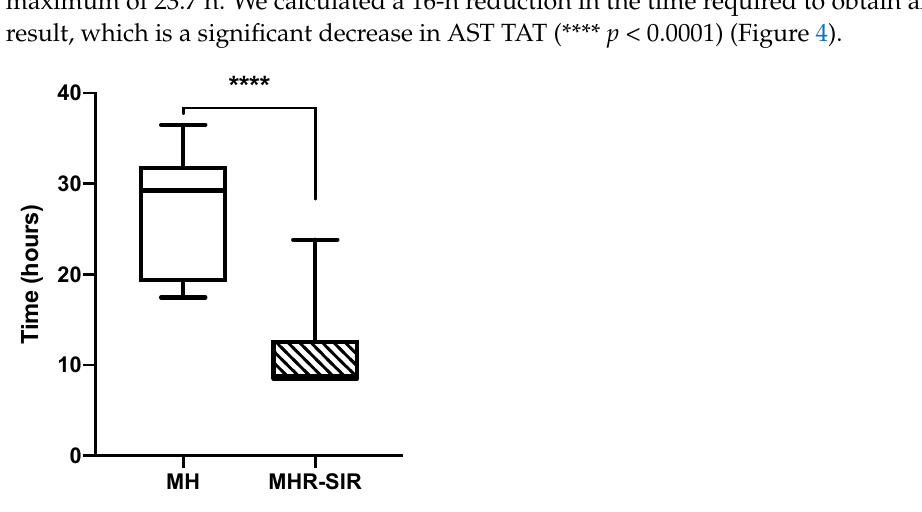
Figure 4. Comparison of time required to obtain the direct AST from a blood culture bottle for MH vs. MHR-SIR (**** p < 0.0001). Boxplots show the 25th and 75th percentile, with the horizontal bar showing the median. Whiskers show the 5th and 95th percentile. The outliers are represented by dots.